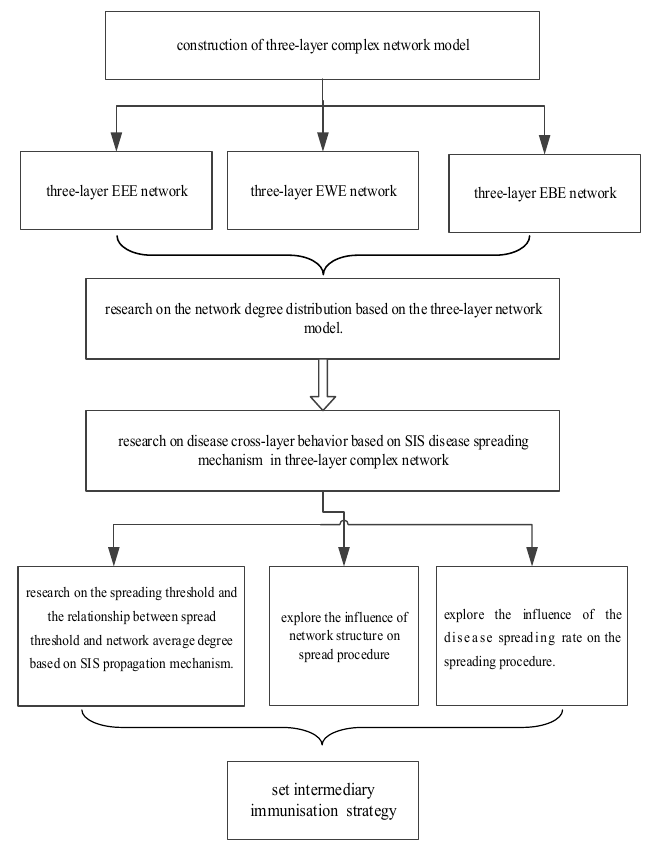
Figure 3. Overview of the proposed